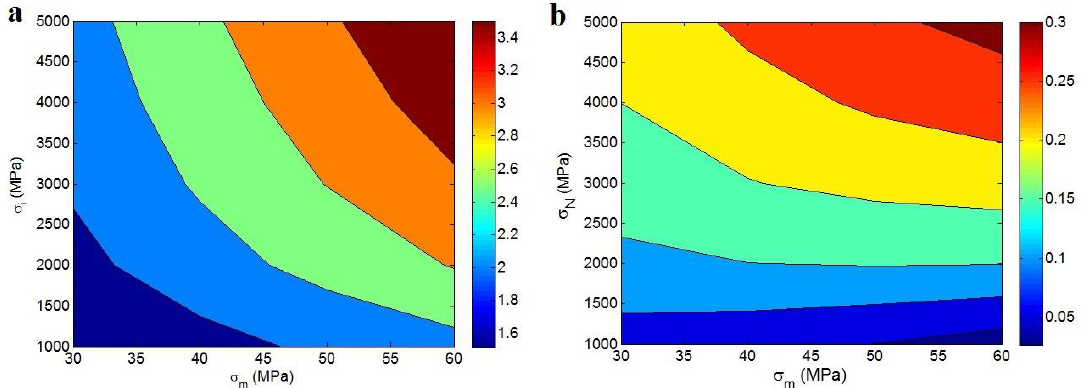
Figure 4. Illustration of ( a ) the influences of “ σ m ” and “ σ i ” parameters on “ S I ” at R = 10 nm, t = 20 nm and α = 300 and ( b ) the roles of “ σ m ” and “ σ N ” in “ S N ” at N = 300 and α = 300.